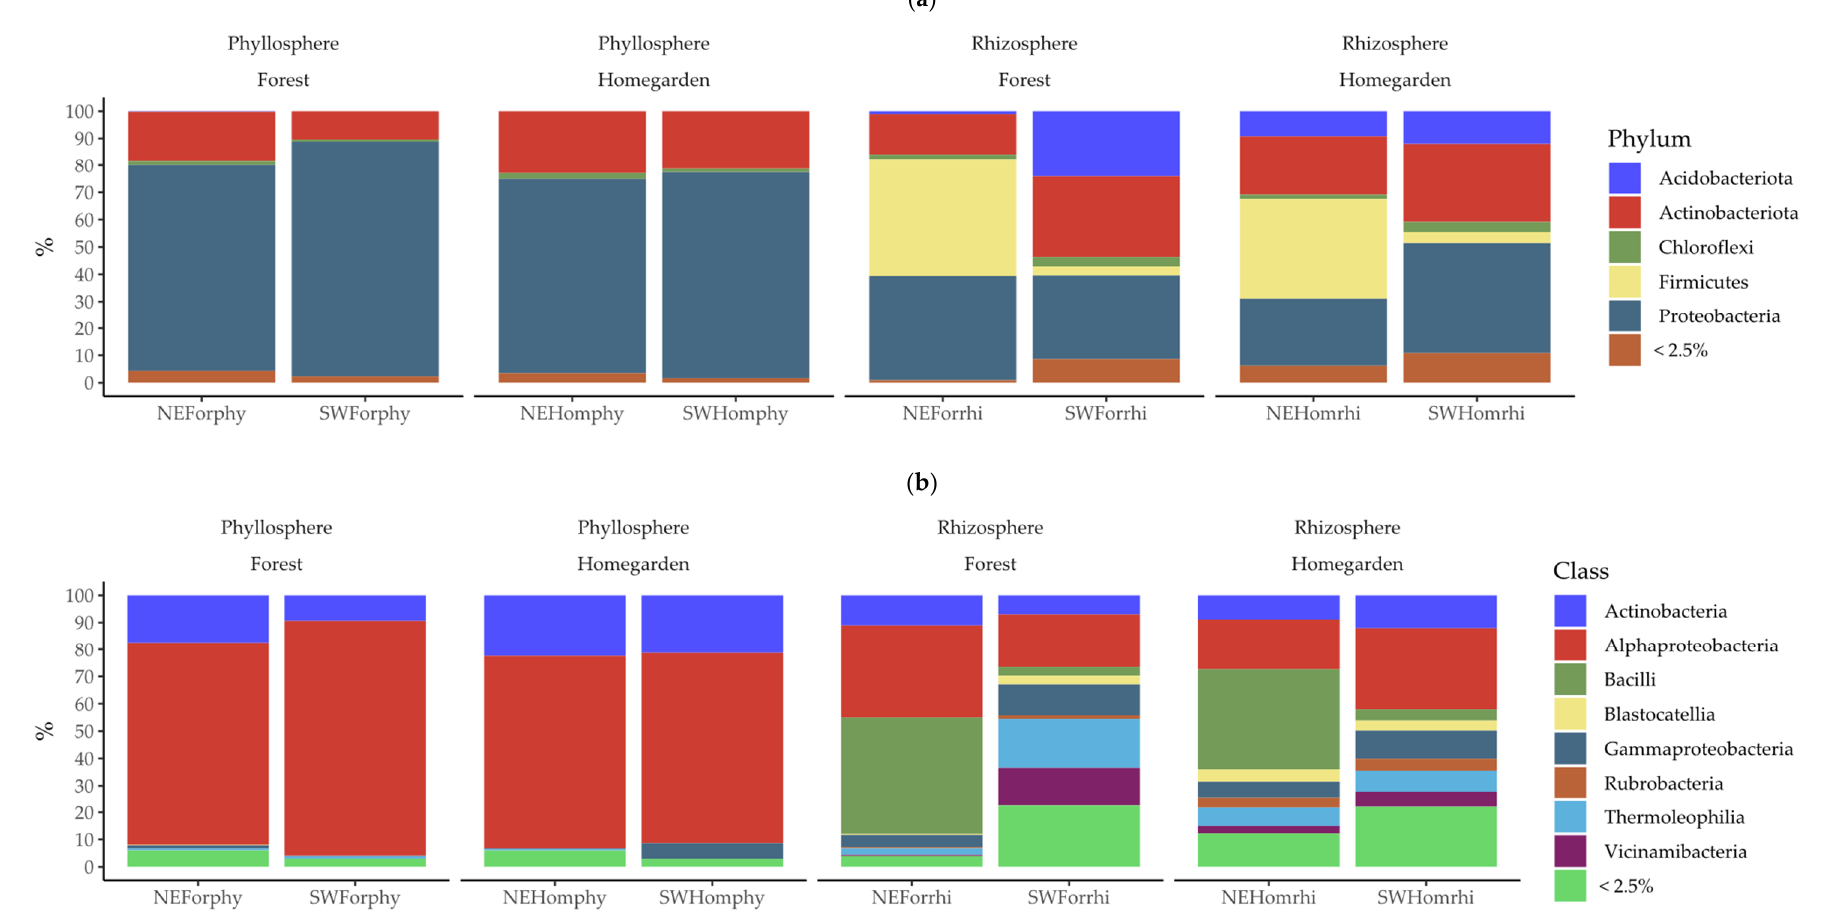
Figure 2. Relative frequency of ( a ) phylum and ( b ) class assigned to 618 bacteria OTUs from phyllosphere and rhizosphere microbiota in Yucatán´s forest and homegarden populations of Cordia dodecandra .